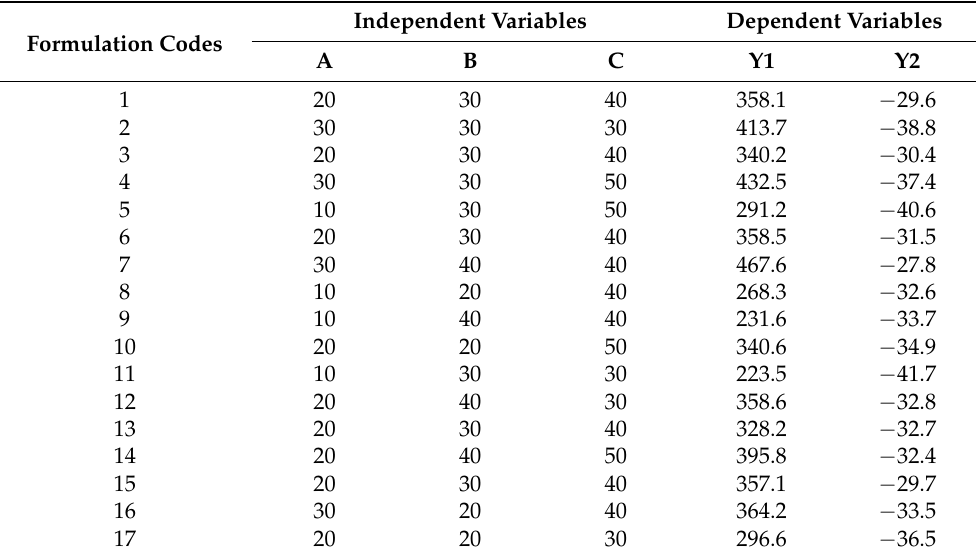
Table 2. Experimental design and values of the responses for the MAD–NLCs formulations. Independent Formulation Codes